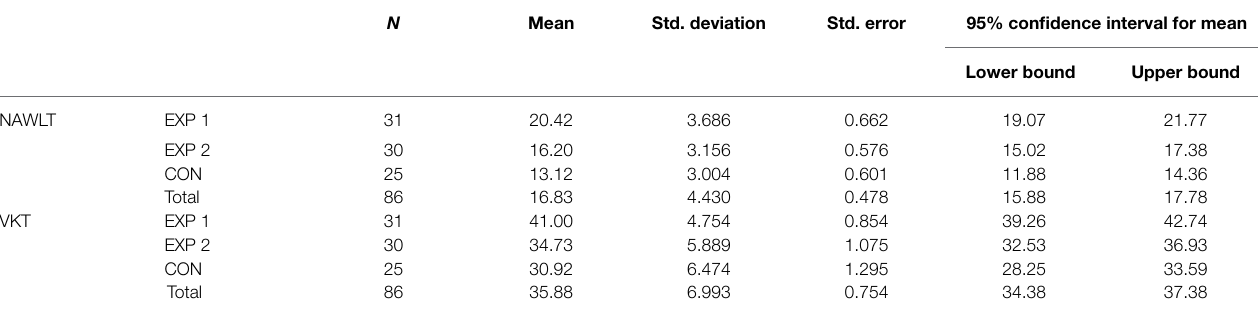
TABLE 4 | Descriptive statistics for post-test results. N Mean Std. deviation